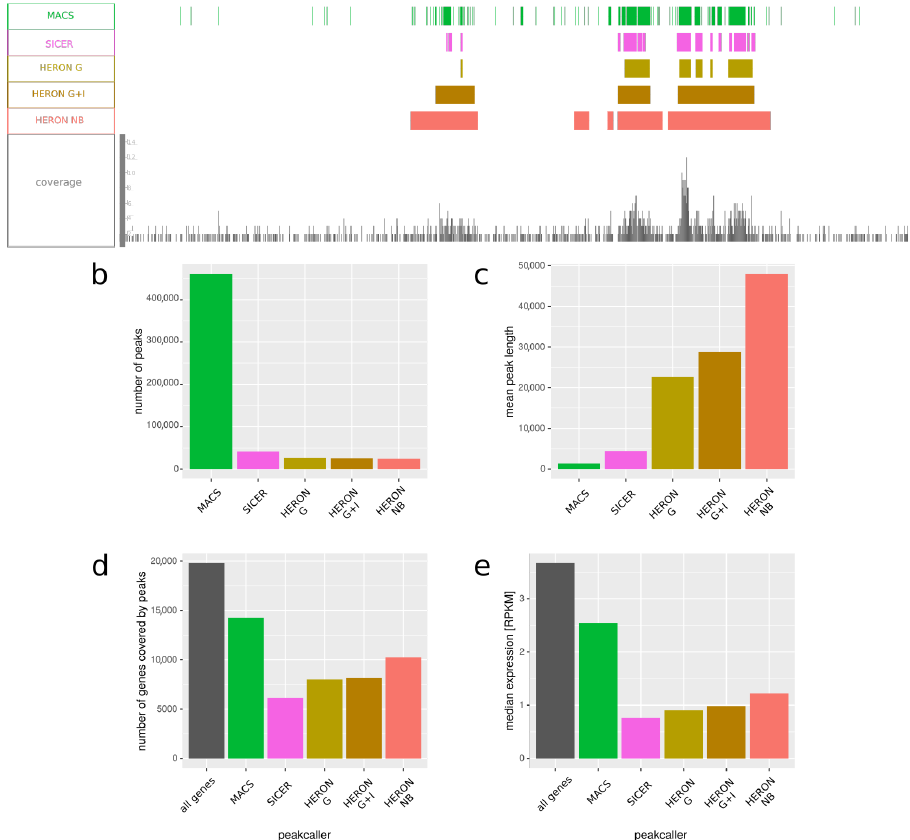
Figure 4. Comparison of peaks called by various methods on H3K27me3 ChIP-seq averaged over 10 samples. The data—including peaks called by MACS—is from Roadmap Epigenomics project. ( a ) Example representative genome fragment from fetal brain, showing peaks called by MACS, SICER, and HERON and the coverage of reads. HERON was run in three settings: “G”—with Gaussian distribution; “G + I”—with Gaussian distribution and with an input file; and “NB”—with negative binomial distribution. ( b ) Number of peaks called by the five approaches. ( c ) Mean length of peaks called by each peakcalling method. ( d ) Number of genes covered by peaks called by different peakcalling methods. First bar represents all the genes present in the annotation used. ( e ) Median expression in RPKM of all genes, compared to the expression of genes that overlap with peaks called by different peakcalling methods. We can see that MACS tends to call a lot of short peaks, which overlap more genes than peaks called by our approach. Furthermore, these genes have on average higher expression than the ones covered by the peaks called by HMM-based method, which might suggest many of them are not in fact within a H3K27me3 domain and the peaks that overlap with them are actually